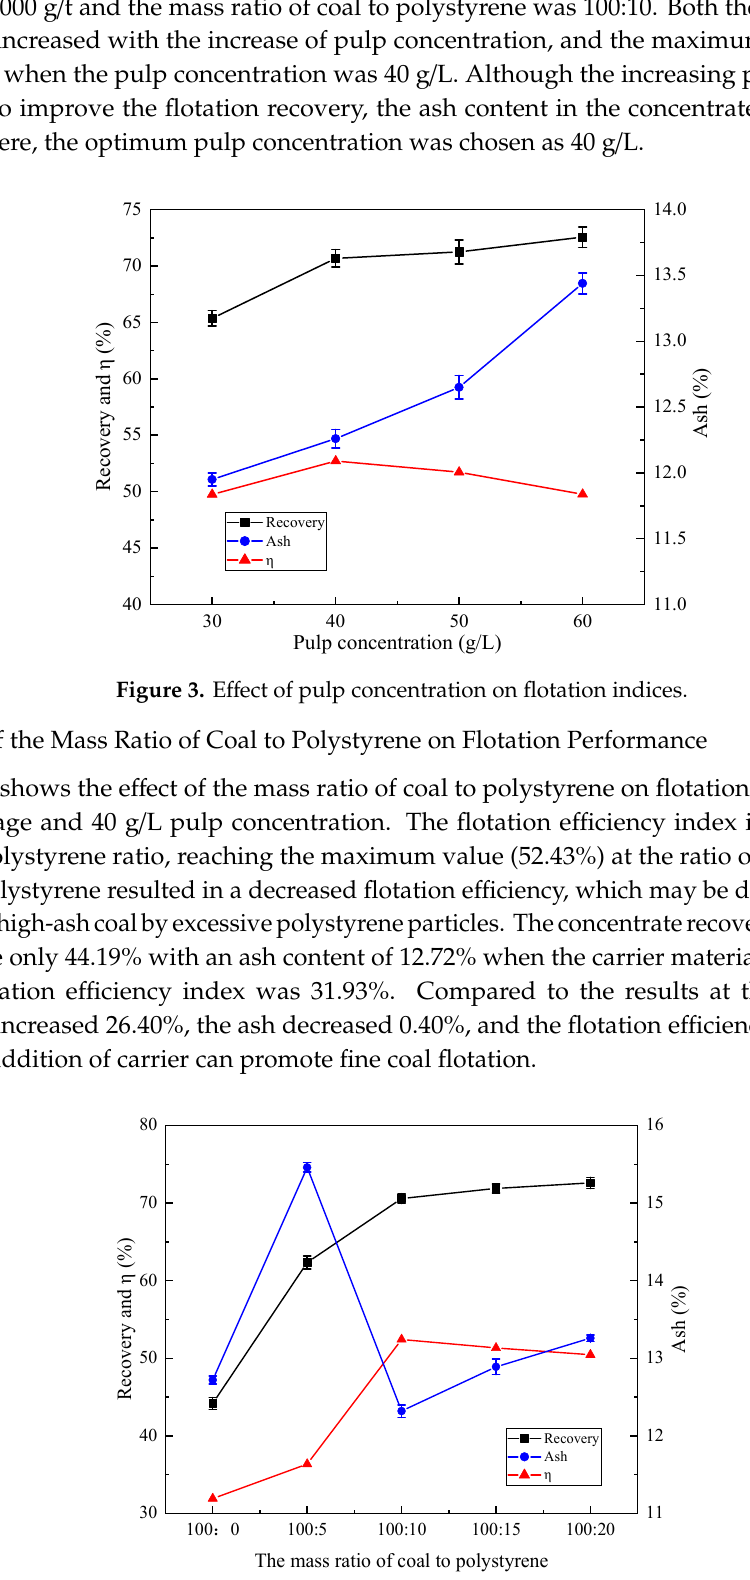
Figure 4. Effect of mass ratio of coal to polystyrene on flotation indices.